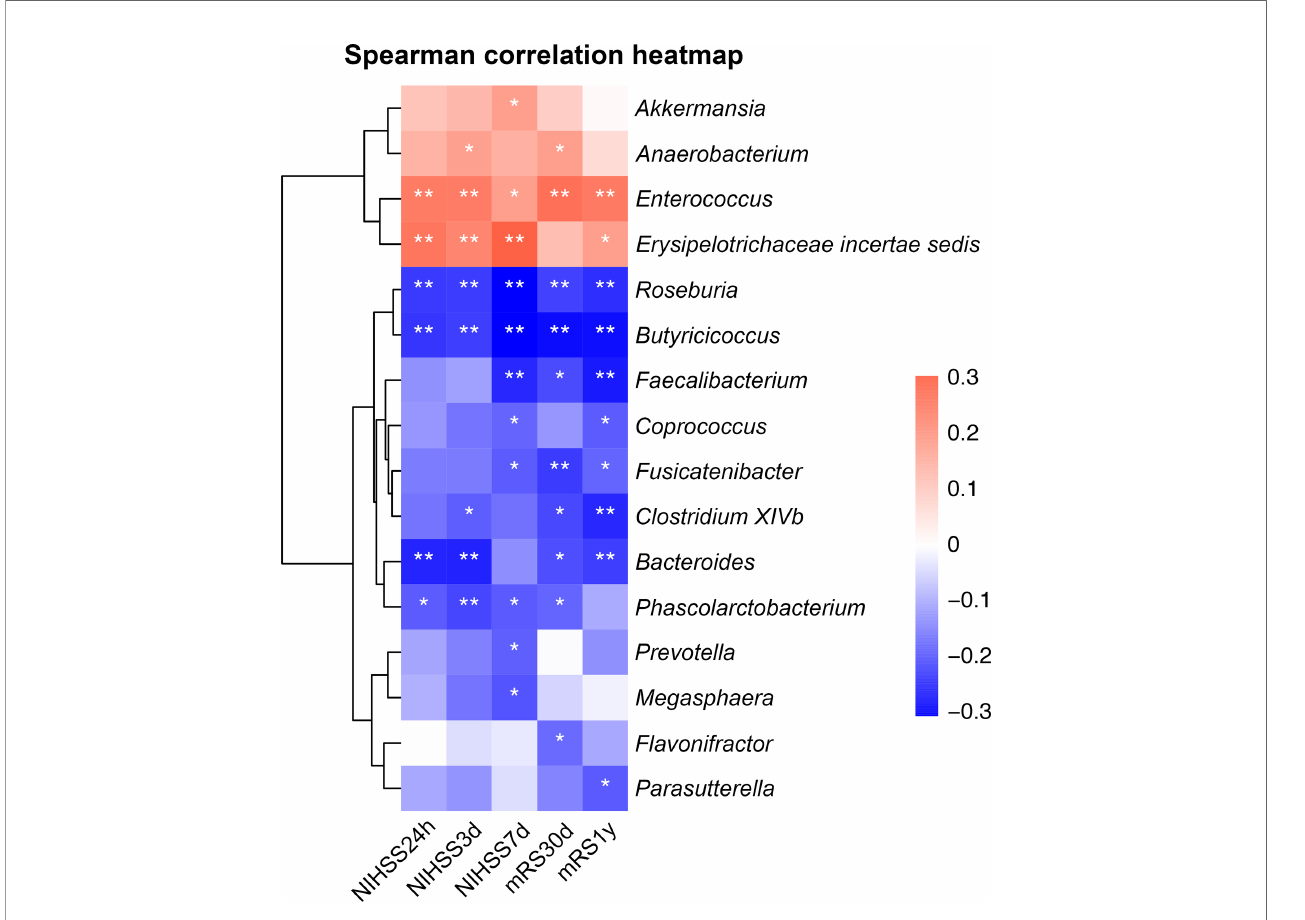
FIGURE 5 | Heatmap of Spearman correlation analysis between gut microbiota and NIHSS score and functional outcomes. * p < 0.05, ** p < 0.01. NIHSS, the National Institute of Health Stroke Scale; mRS, modi fi ed Rankin scale